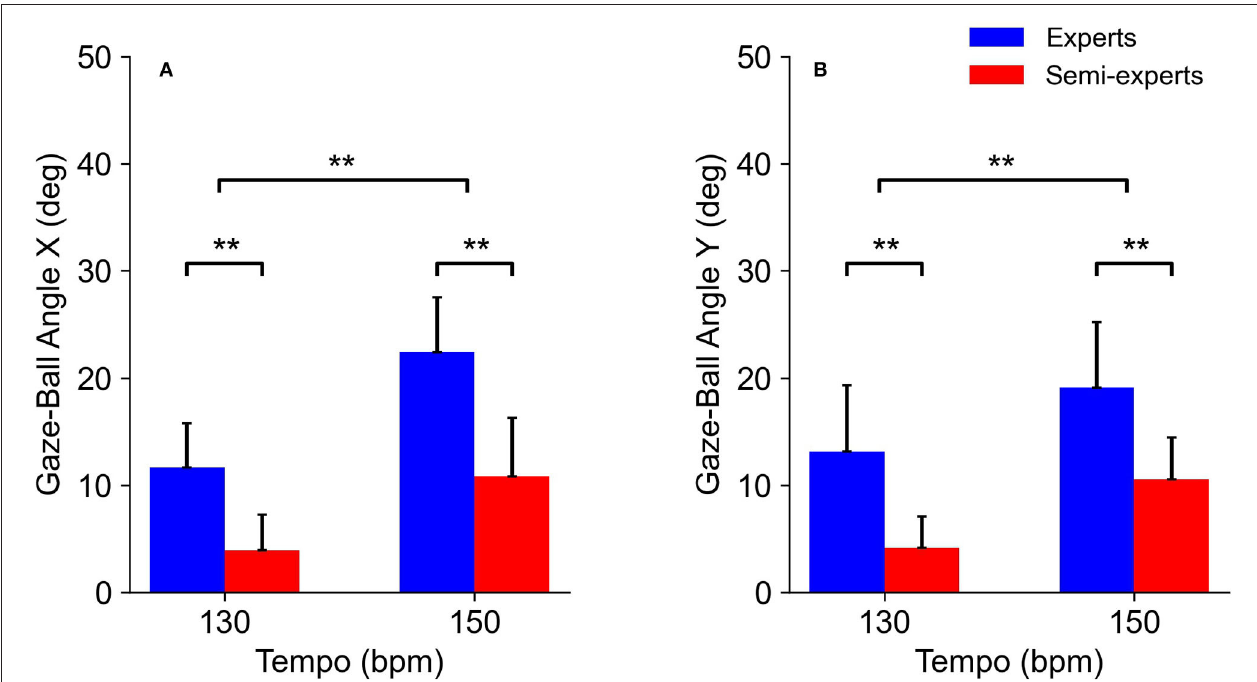
FIGURE 5 | Comparison of the gaze-ball angle X (A) and Y (B) of the expert and semi-expert groups in the two tempo conditions.